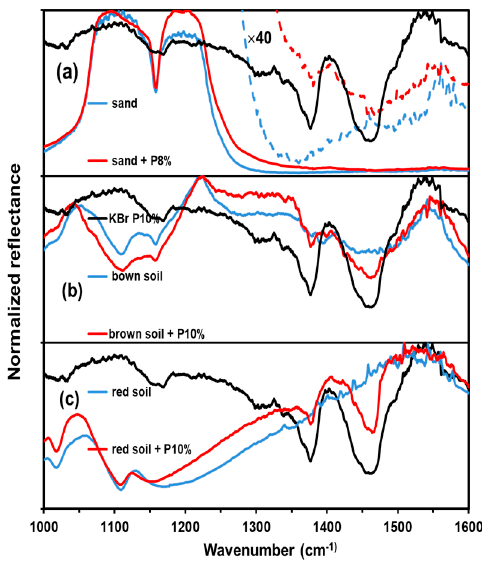
Figure 3. Reflectance spectra of soils with and without the pollutant. ( a ) Sea sand + 8% w / w petroleum (sand + P8%); ( b ) brown soil + 10% w / w petroleum (brown soil + P10%); and ( c ) red soil + 10% w / w petroleum (red soil + P10%).